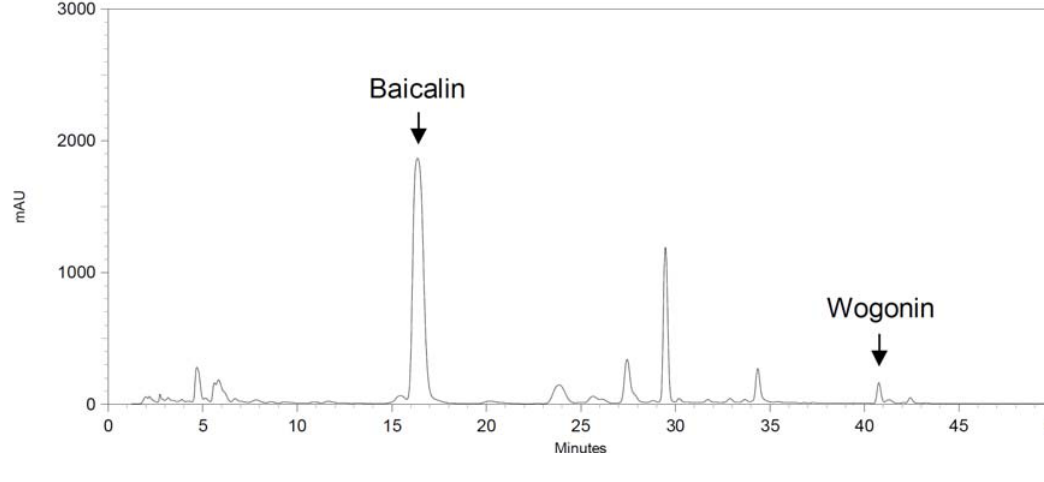
Figure 7. HPLC chromatogram of baicalin and wogonin in the boiling-water extract of S. baicalensis (SB-WE). The respective retention times of baicalin and wogonin were 16.5 and 40.9